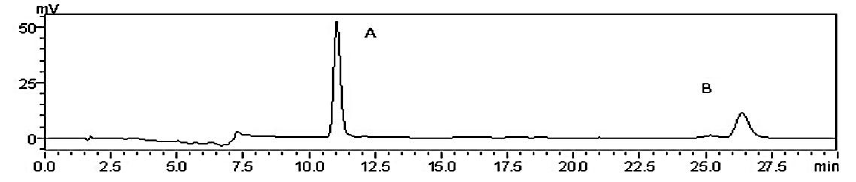
Figure 1. HPLC analysis of CPhGs. A, echinacoside; B, acteoside.